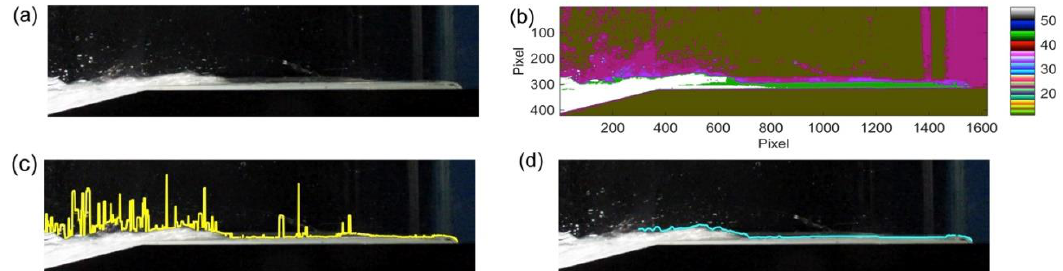
Figure 5. Example of test with R c / H s = + 0.5. Steps of the implemented image processing to detect the free surface: original cropped frame ( a ), classification in clusters ( b ), and initial ( c ) and final detection of the free surface over the dike crest after the filtering process ( d ).